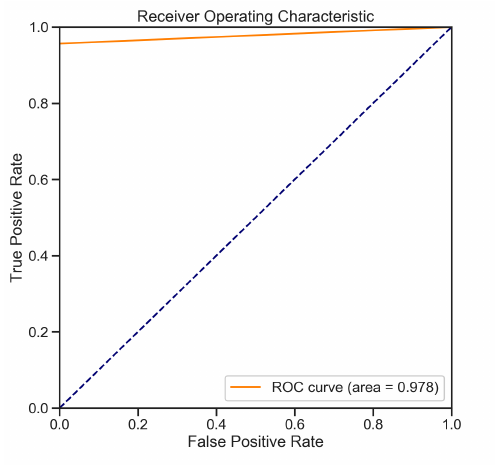
Figure 19. ROC case4 in case 4 in Table